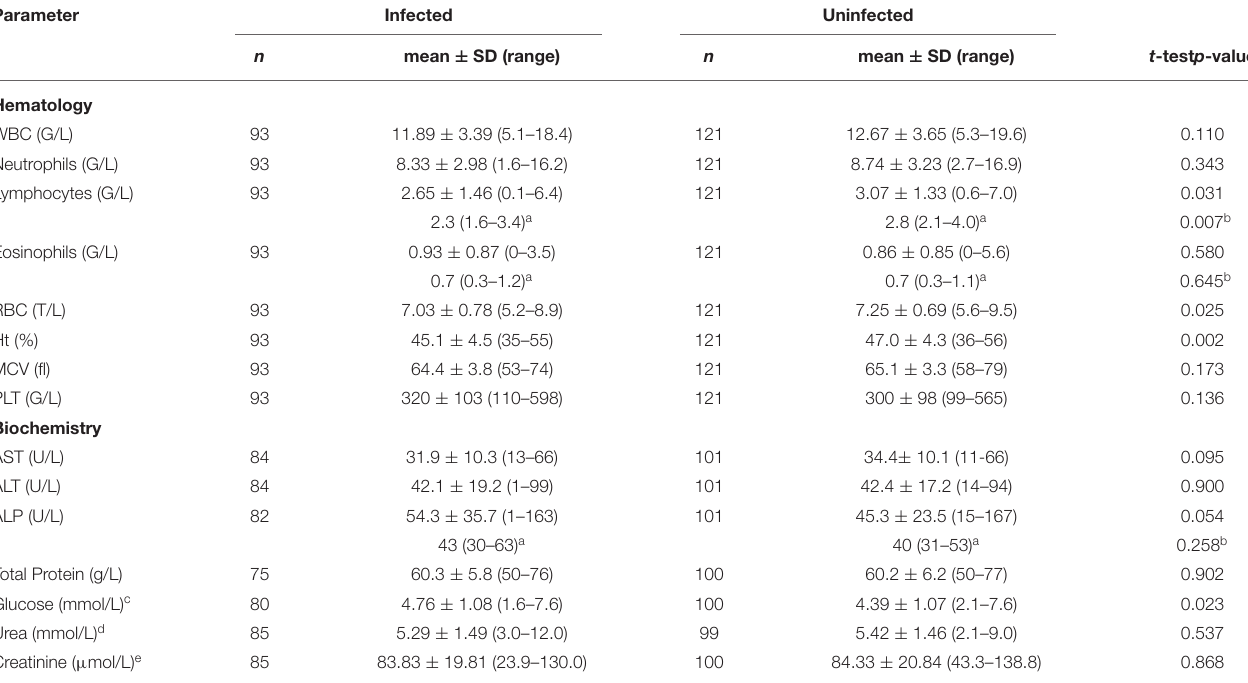
TABLE 3 | Hematological and biochemical parameters in clinically healthy dogs with blood check-up results within normal reference ranges.